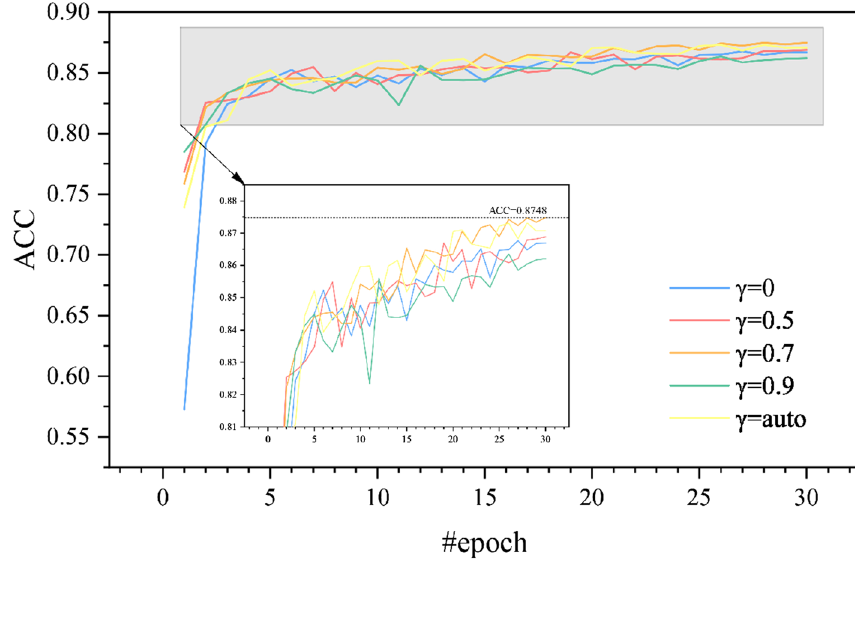
Fig. 8 Accuracy comparison of different optimizers with dropout